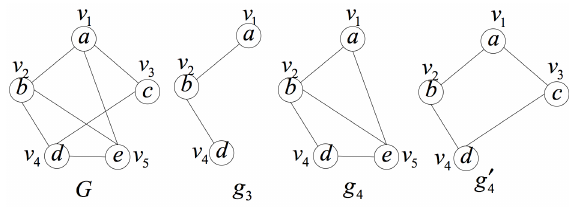
Figure 6. An example of the induced subgraph space search